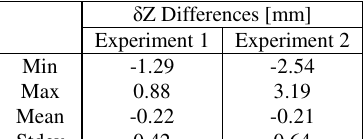
Table 2. Statistical properties for the deflection differences between the photogrammetric system and the laser scanner for all available plates and all observed